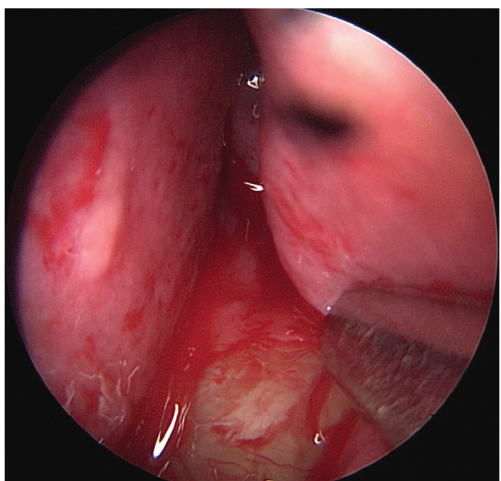
Figure 1: Endoscopic examination of the nose showing a large, left-sided nasal polypoid mass occluding the entire left nasal cavity.